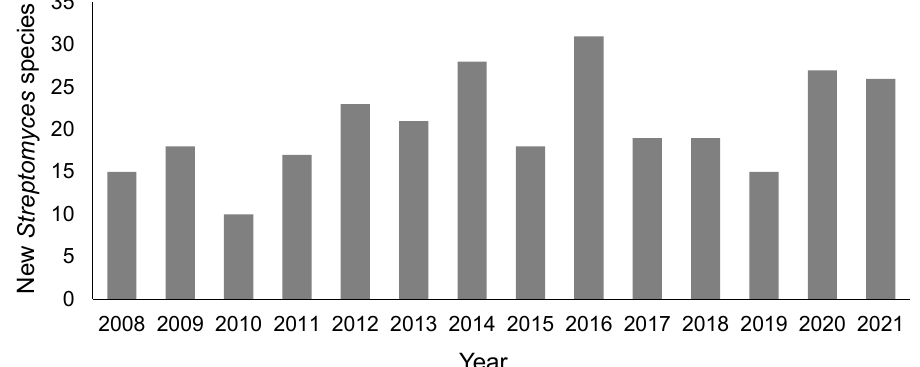
Figure 1. Annual numbers of newly proposed Streptomyces species with validly published names. The numbers are based on lists that are annually published in the SAJ News of Actinomycetologica (https://www.actino.jp/journal/index.html, accessed on 20 October 2022) No. 1 as the List of new scientific names and nomenclatural change in the phylum Actinobacteria ( Actinomycetota from 2022) validly published in each year.